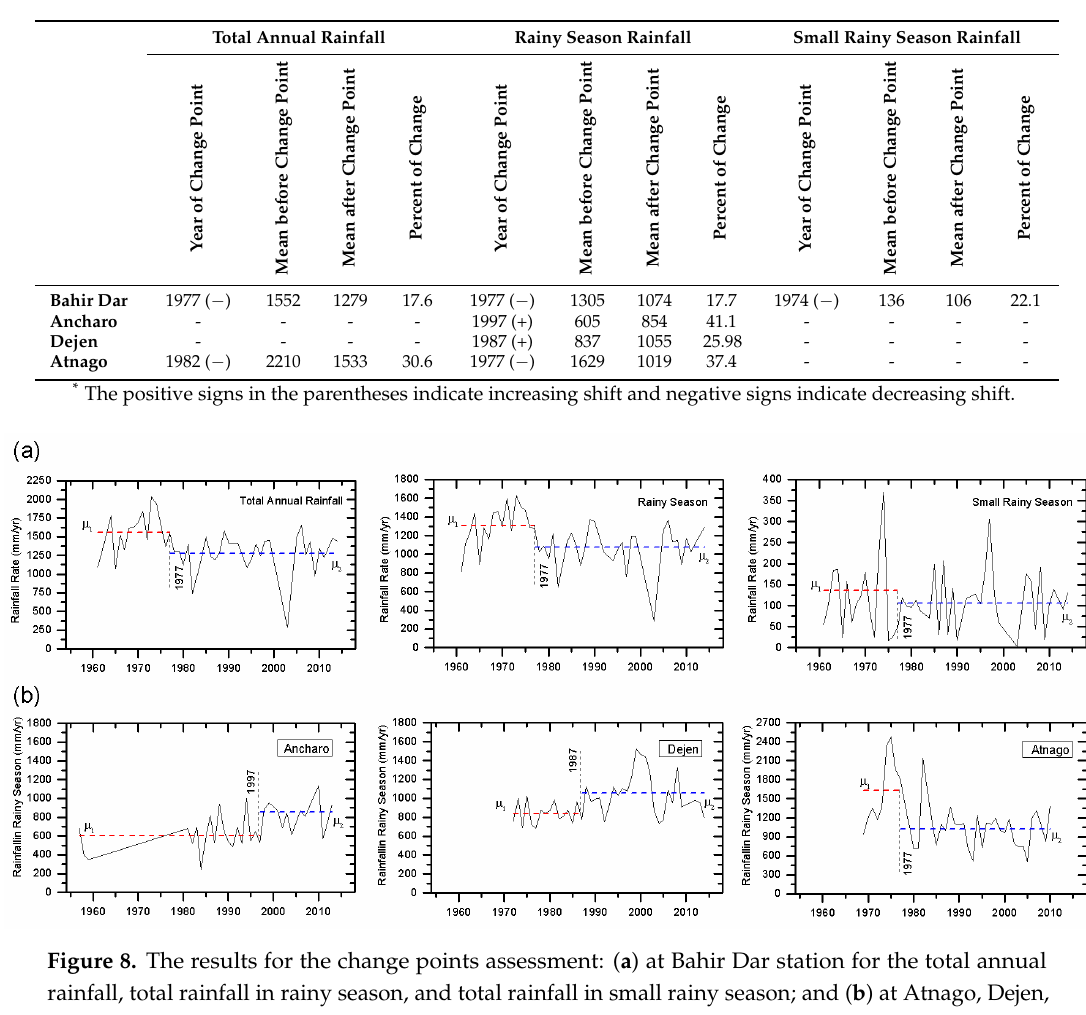
Table 4. Summarized results of Pettitt test for the total annual and seasonal rainfall time series a .